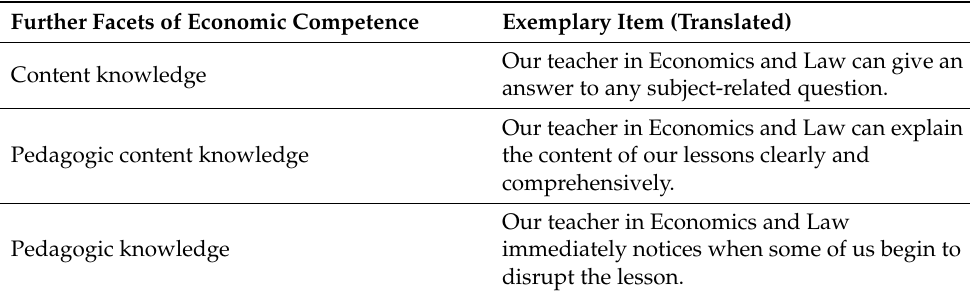
Table 4. Exemplary items for professional knowledge that students perceive in their